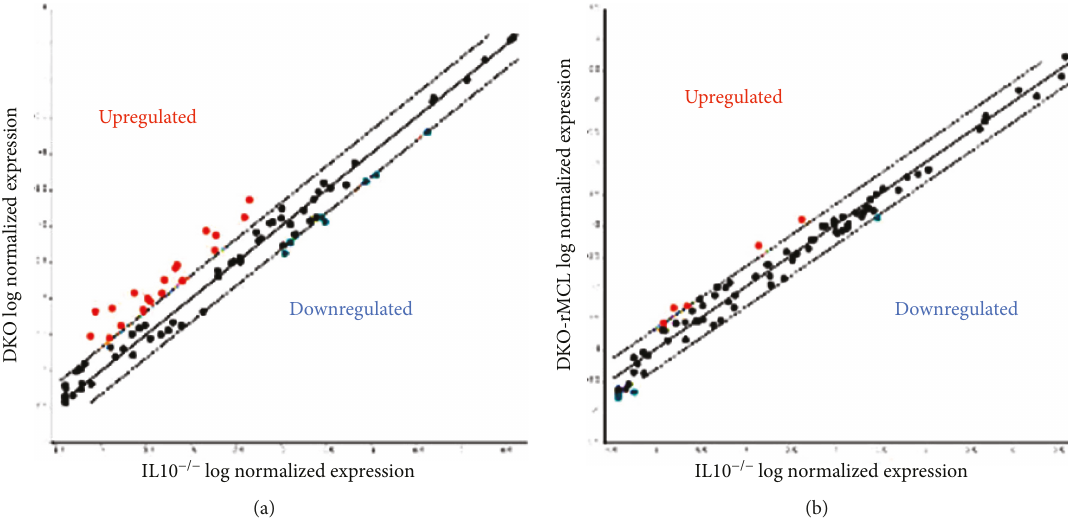
Figure 5: Mast cell de fi ciency in colitis results in dysregulation of many cytokines and chemokines. (a) Scatter plot representation of average fold change of 84 di ff erent cytokine and chemokine genes in IL10 − / − compared to DKO mice from RNA extracted from whole colon. Dots above the lines are higher in DKO than in IL10 − / − mice, and dots below the line are greater than 2-fold decreased in DKO compared to IL10 − / − mice. (b) Reconstitution of DKO mice with BMMCs ameliorates the alteration of cytokines. Represents averaged fold change values in n = 5 mice per e ff ects. Heparin binds leukocyte and platelet selectins and